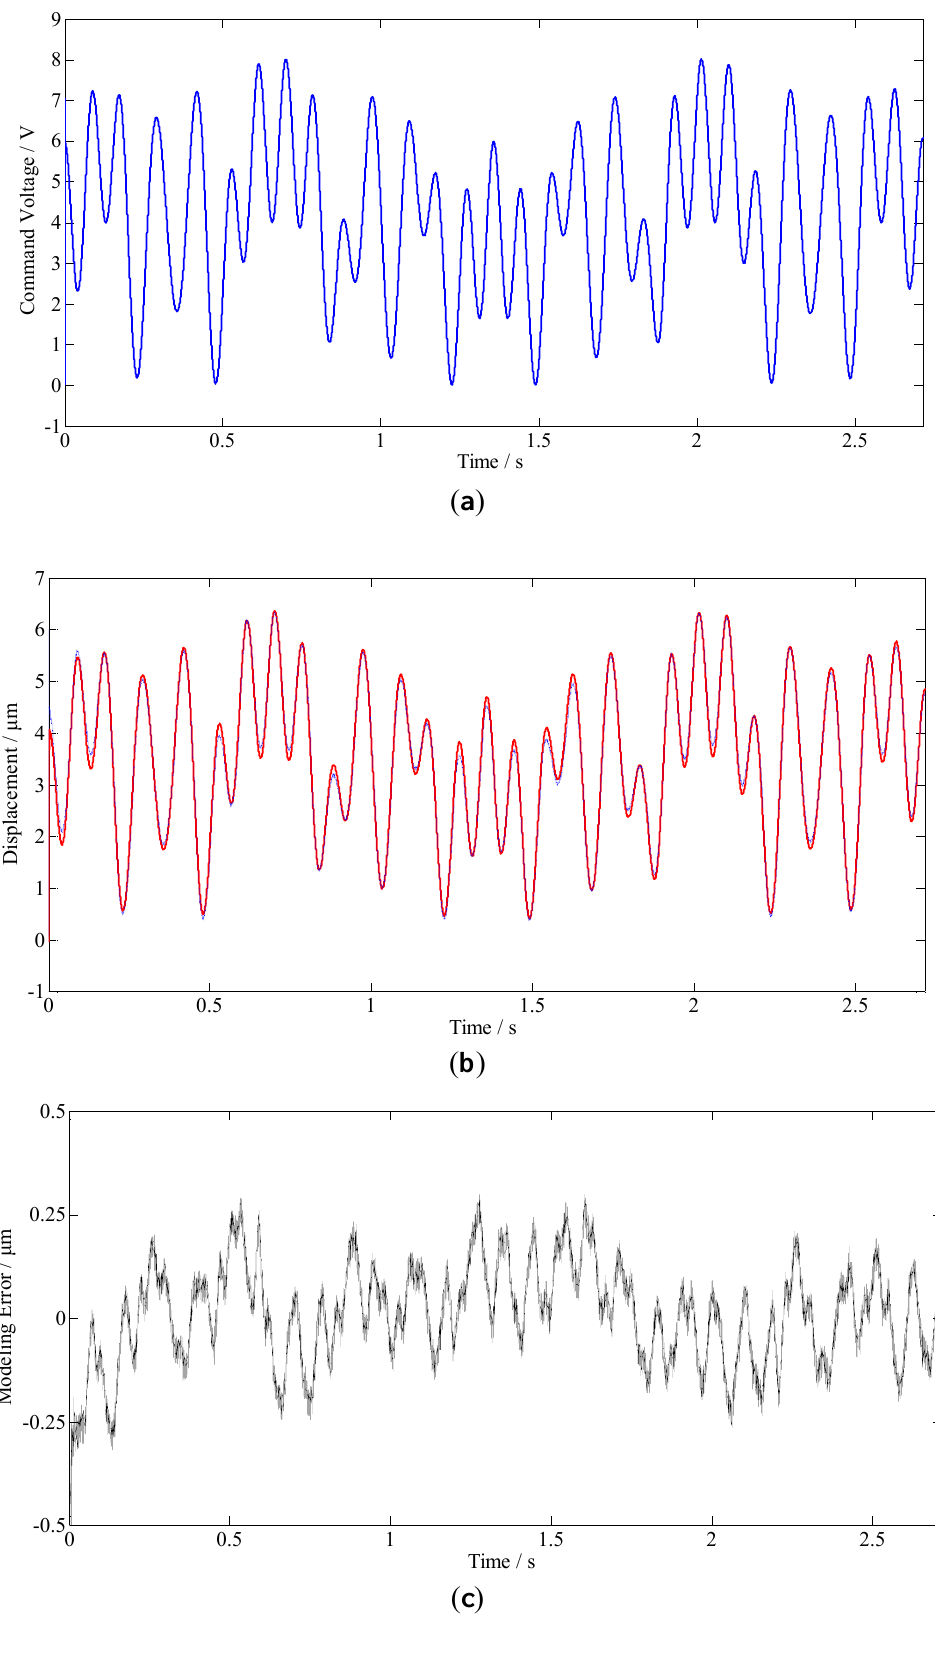
Figure 11. Modeling results (In Figure 11b, the red line and blue line denote the output of the model and the FTS, respectively.): ( a ) The control voltage; ( b ) Responses of the FTS and the proposed model; ( c ) Modeling